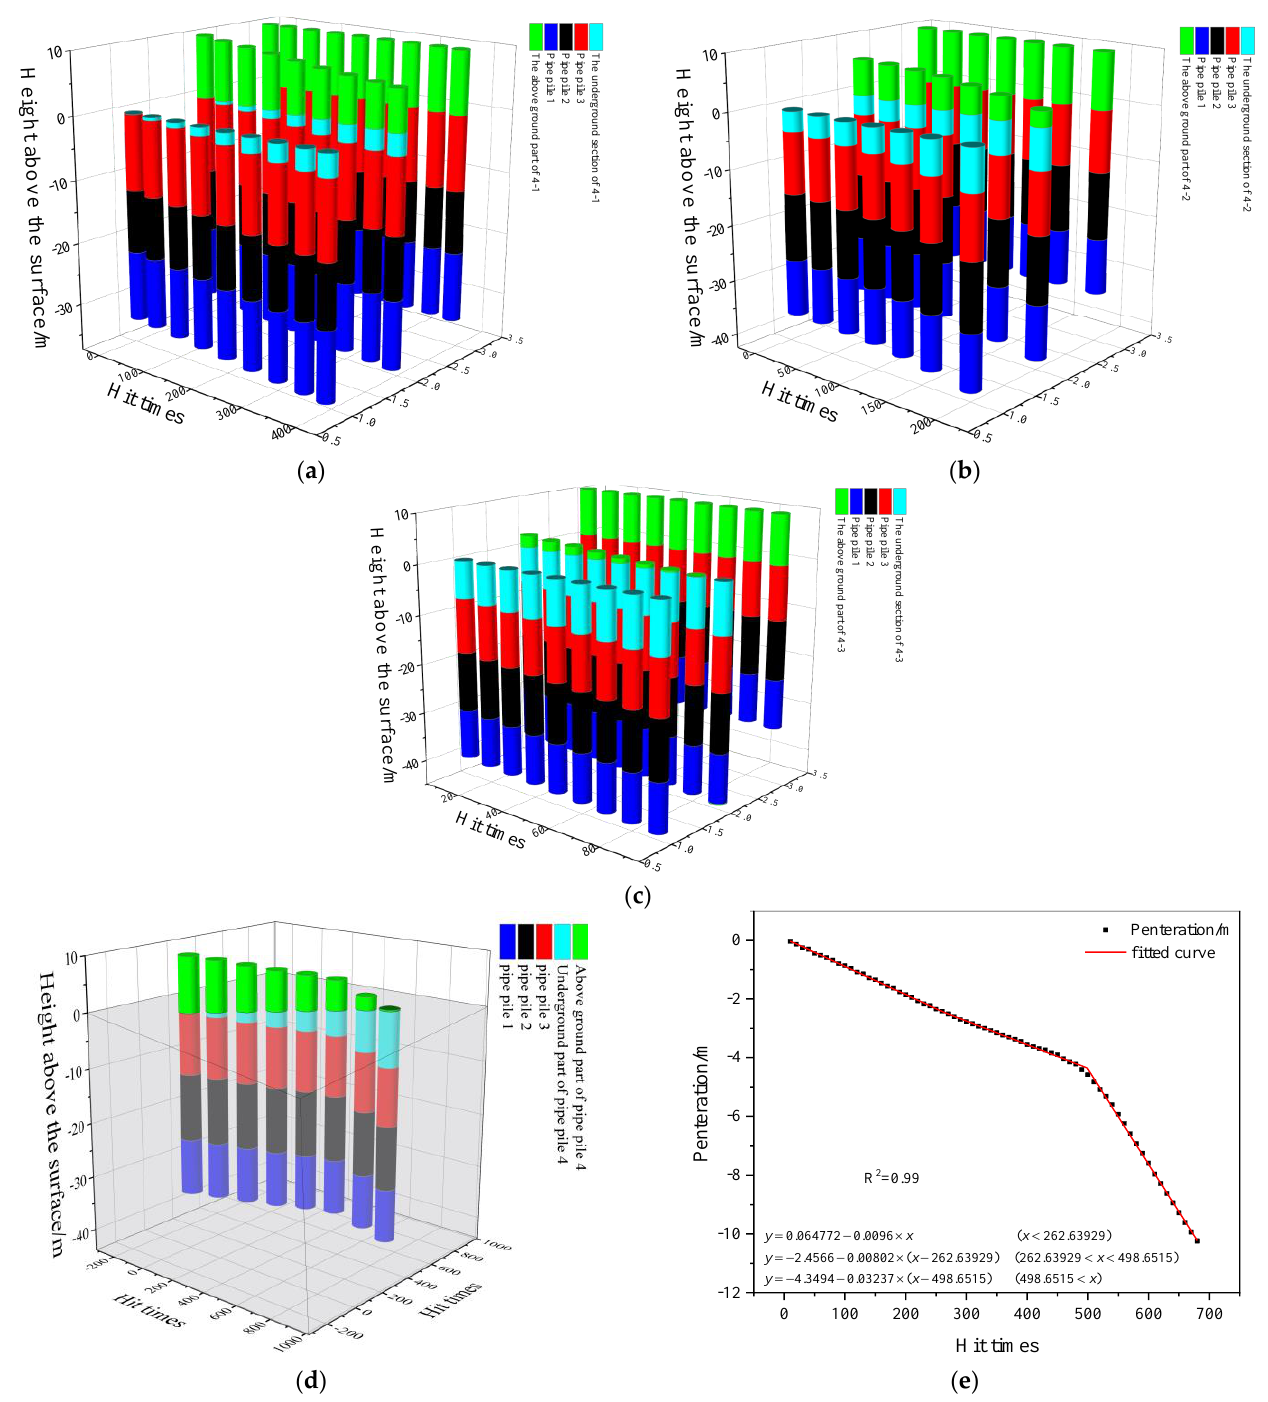
Figure 11. Diagram of penetration evolution of the 4th pipe pile at pile 6, showing the ( a ) schematic diagram of pipe pile penetrated the strata in first monitoring stage, ( b ) schematic diagram of pipe pile penetrated the strata in second monitoring stage, ( c ) schematic diagram of pipe pile penetrated the strata in third monitoring stage, ( d ) spatial diagram of penetration evolution law, and ( e ) fitting analysis of penetration evolution law.